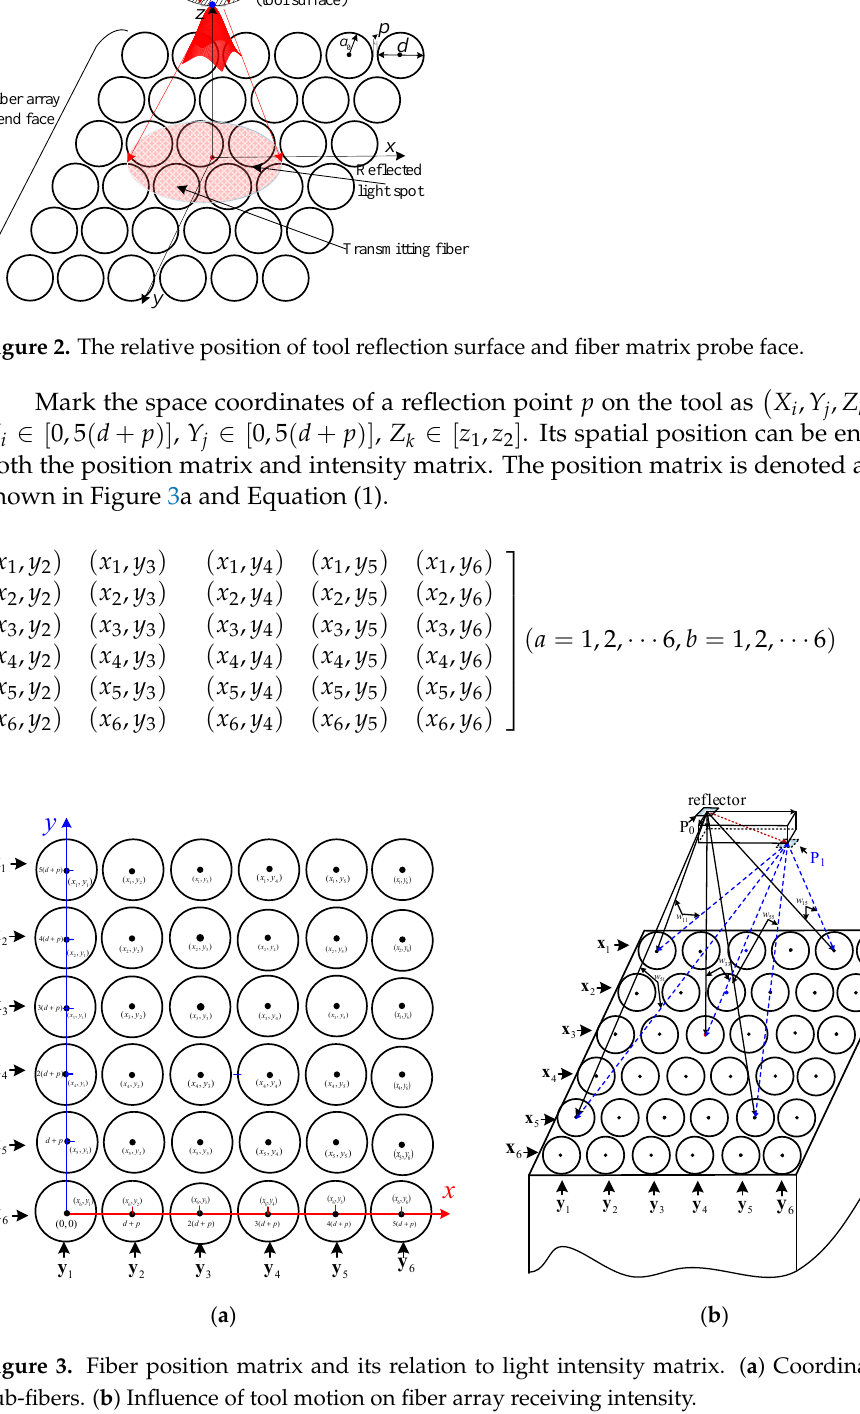
Figure 3. Fiber position matrix and its relation to light intensity matrix. ( a ) Coordinates of the sub-fibers. ( b ) Influence of tool motion on fiber array receiving intensity. The light intensity matrix is denoted as I ab , and the intensity of each element depends on the intensity of the light reflected back by each fiber, shown in Equation (2).